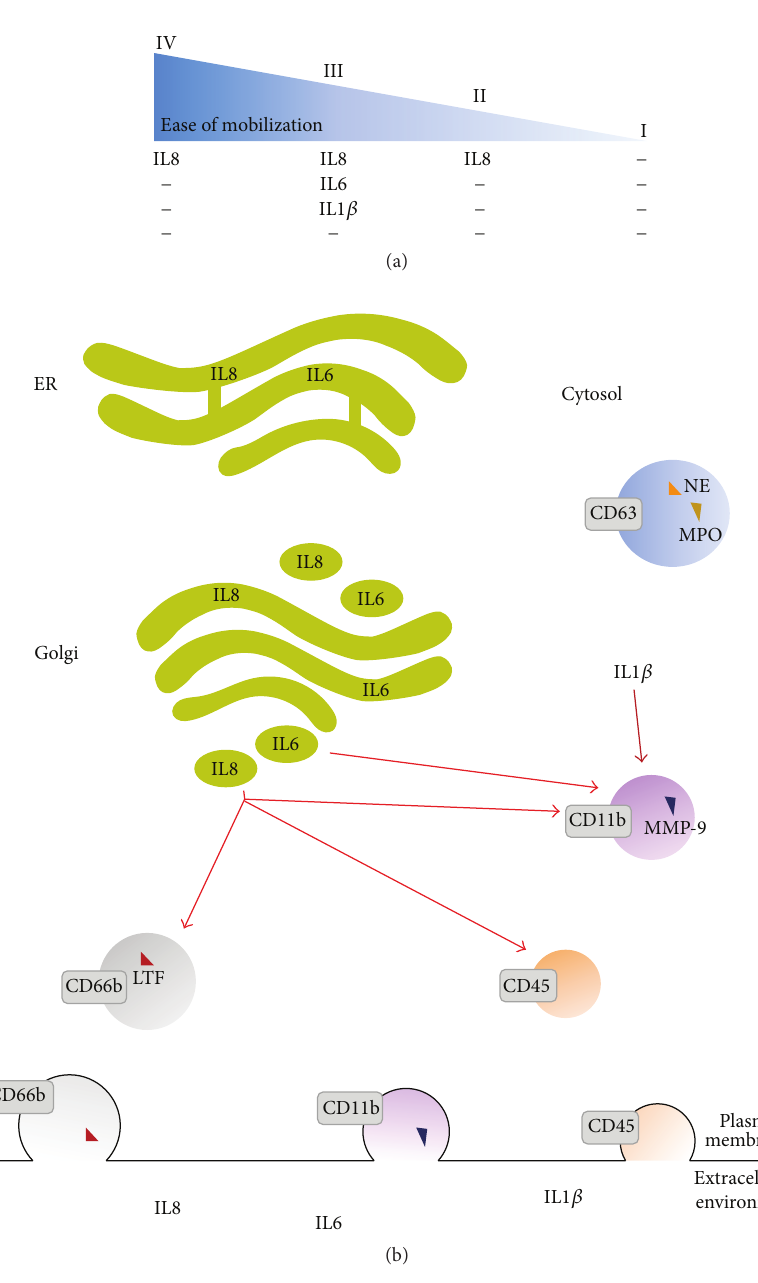
Figure 6: Hypothetical models of fitted cytokines and granules in human neutrophils. (a) Neutrophil-derived cytokines are released in a hierarchical sequence coincident with the roles of granules (IV secretory vesicles, III gelatinase granules, II specific granules, and I azurophil granules) during the microbial elimination processes and inflammatory response. (b) Cytokines and granules are released in a concurrent fashion but could additionally be localized in or mobilized to the different granule types. Classical secretory pathways are mediated through the endoplasmic reticulum (ER) and Golgi complex (IL6 and IL8). IL1 𝛽 is secreted on a nonconventional pathway. Possible routes for cytokine trafficking (after ER-Golgi or after cleavage) and mobilization to the plasma membrane relative to degranulation are shown in red. Different types of granules are characterized by their CD markers and proteolytic enzymes (triangles): CD63, myeloperoxidase (MPO), and neutrophil elastase (NE) for azurophil granules; CD66b and lactoferrin (LTF) for specific granules; CD11b and matrix metallopeptidase-9 (MMP-9) for gelatinase granules; and CD45 for secretory vesicles. Upon mobilization of the granules to the plasma membrane, granule docking and fusion lead to the translocation of the CD markers to the plasma membrane and the release of proteolytic